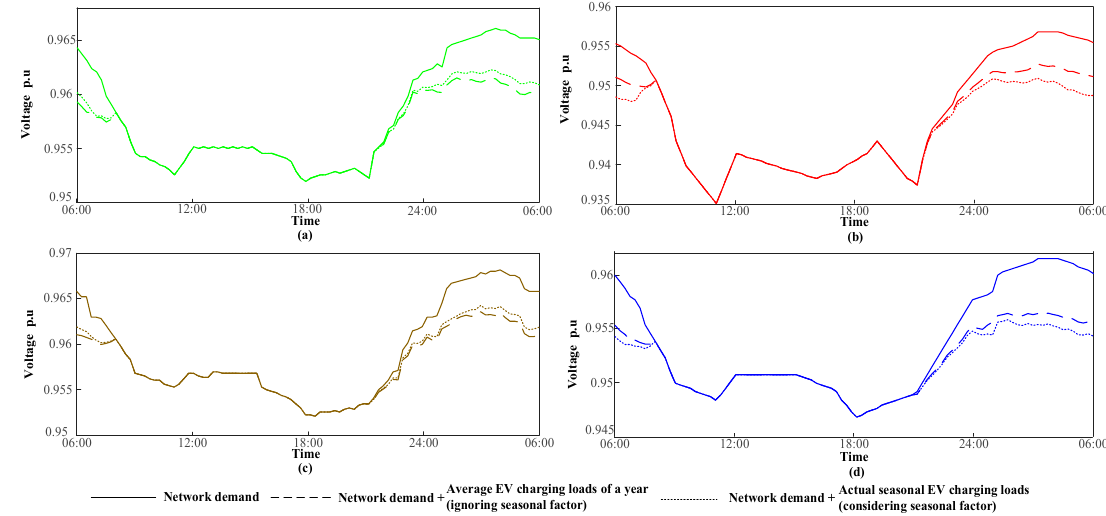
Figure 11. Optimized daily note voltage curves of the given network by applying the proposed charging strategy; ( a ) spring, ( b ) summer, ( c ) autumn, ( d ) winter.